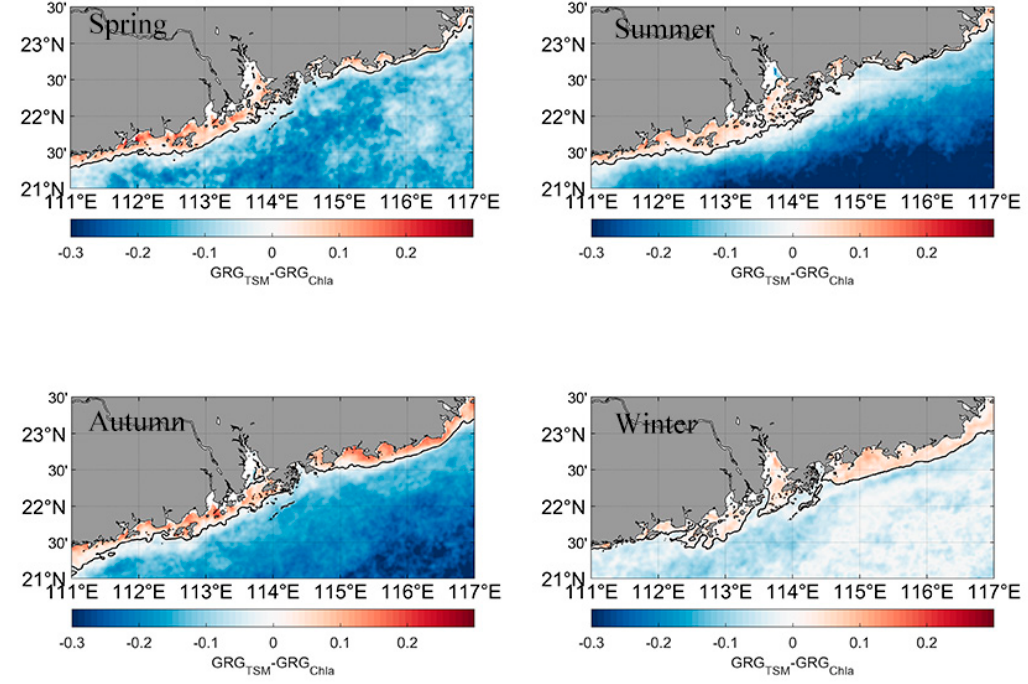
Figure 9. Distribution of dominant water constituents in the four seasons.